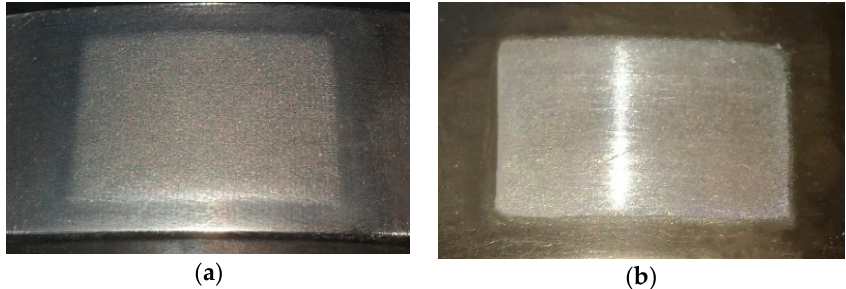
Figure 8. Images of the printed patterns in ECM. ( a ) 106 g/L NaNO 3 ; ( b ) 106 g/L NaNO 3 + 30 g/L NaOH.